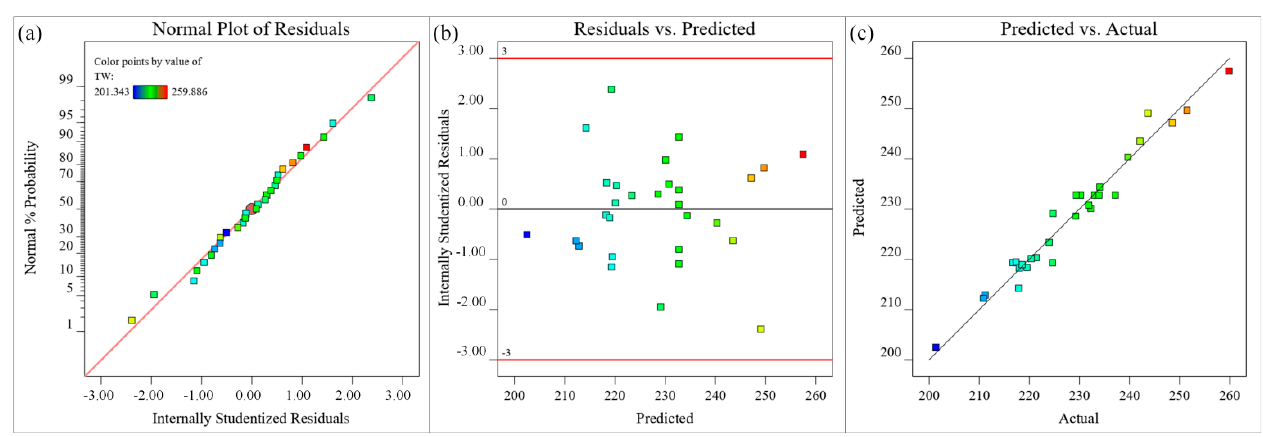
Figure 12. Diagnostic plots for top width (µm) ( a ) Normal plot of residuals, ( b ) Residuals versus predicted plot, ( c ) Predicted versus actual values plot.